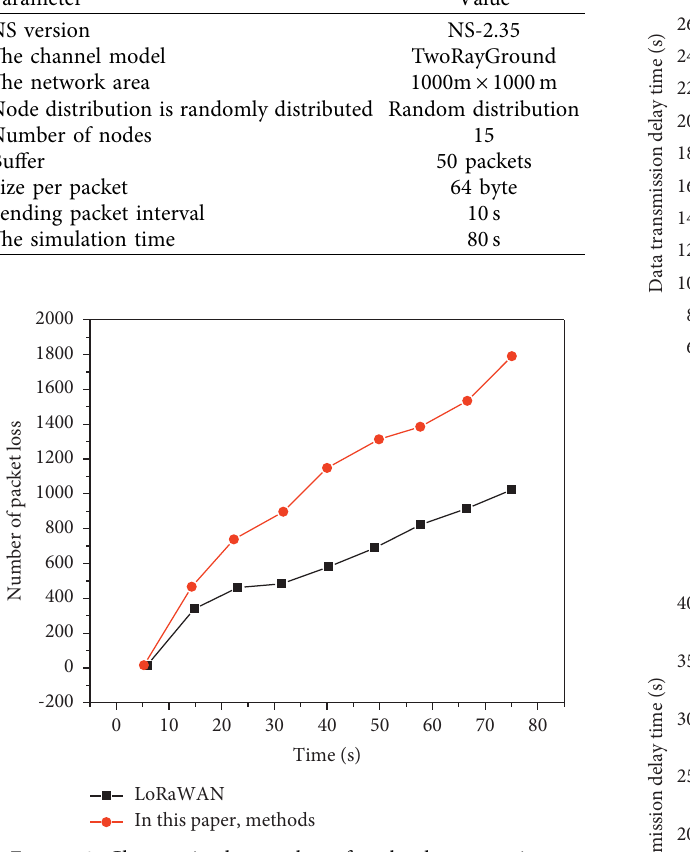
Figure 3: Changes in the number of packet loss over time.